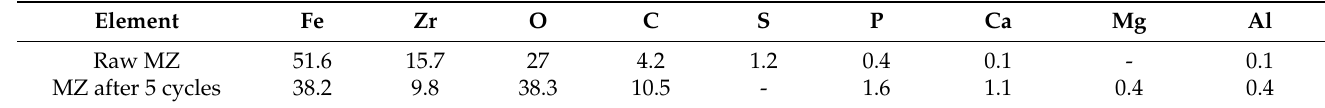
Figure 9. EDS spectra of MZ surface before adsorption ( a ) and after five cycles ( b ). Table 6. Weight percentage of elements on MZ surface before adsorption and after 5 cycles (%).